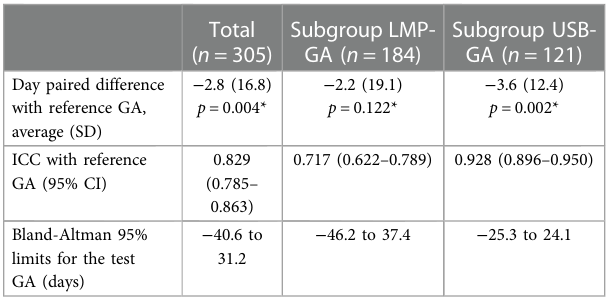
TABLE 2 Agreement between test and reference gestational age in low- birth-weight newborns.